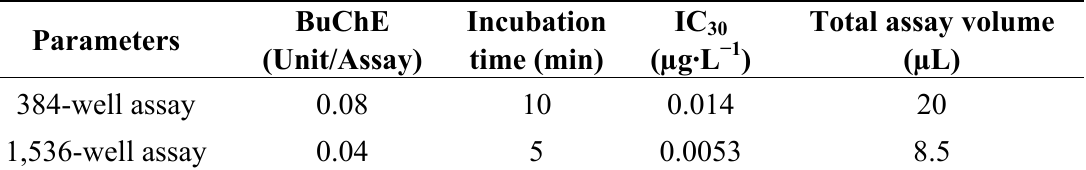
Table 4. Analytical performance of the bioassay in 384 and 1,536 well plate format.